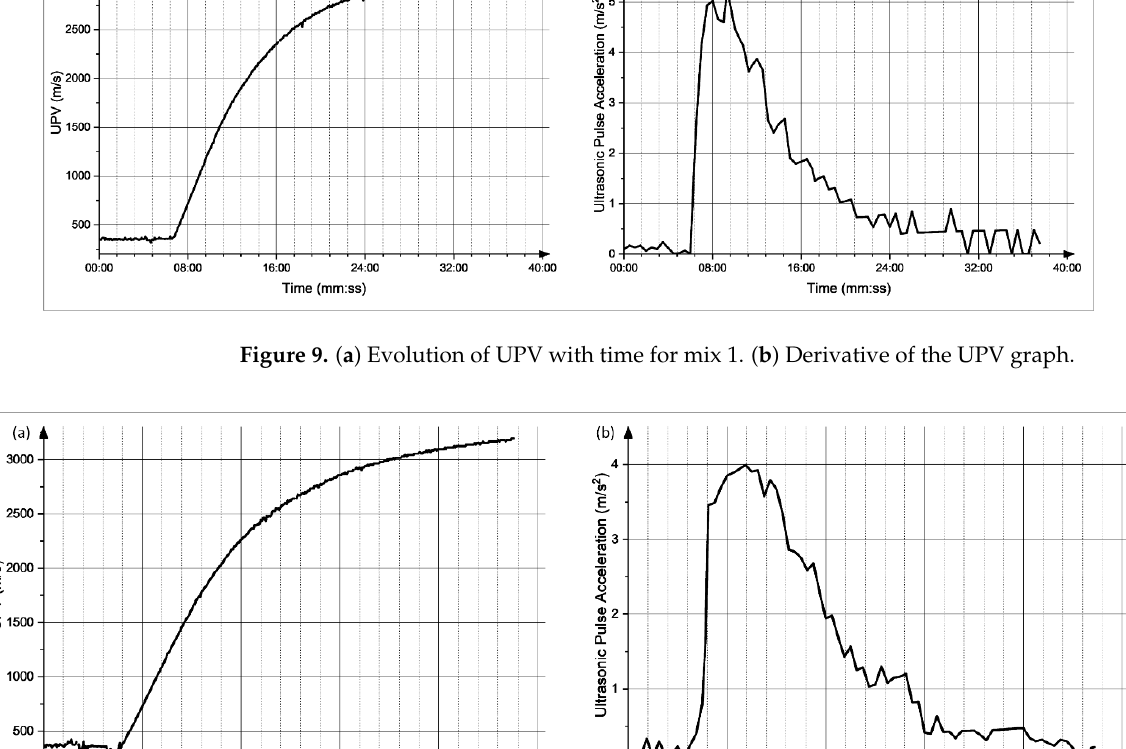
Figure 11. ( a ) Evolution of UPV with time for mix 4. ( b ) Derivative of the UPV graph. Figure 12. ( a ) Evolution of UPV with time for mix 5. ( b ) Derivative of the UPV graph.